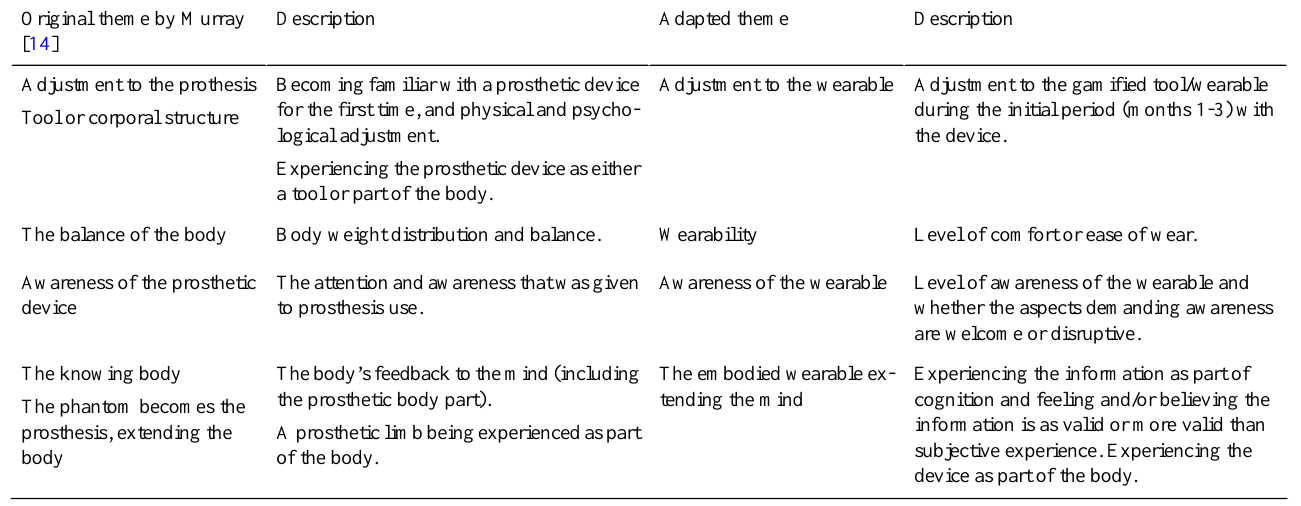
Table 1. Original themes of Murray and adapted themes with